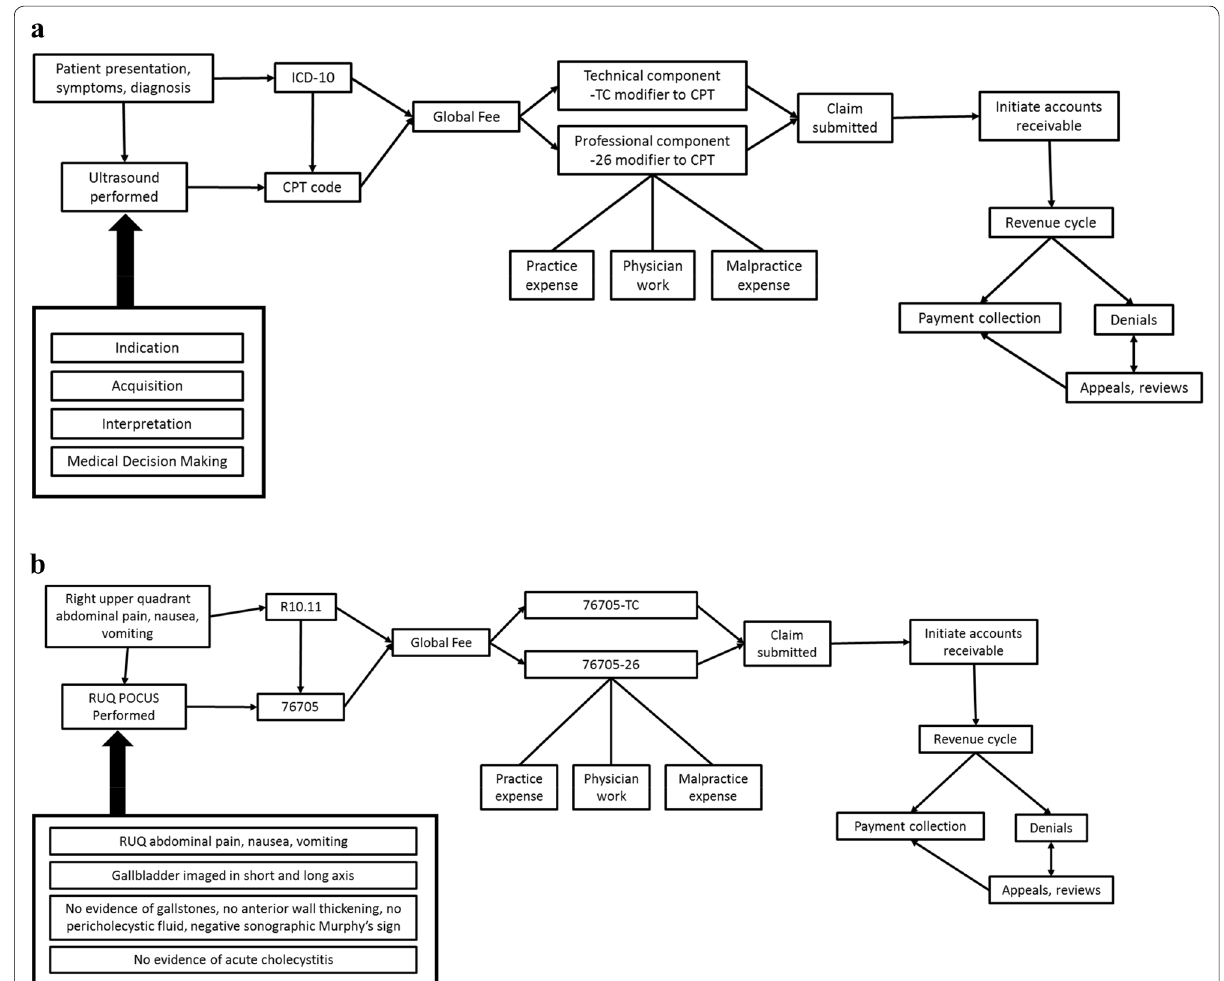
Fig. 4 Process flowchart illustrating the Billing I-AIM method in point-of-care ultrasound billing and